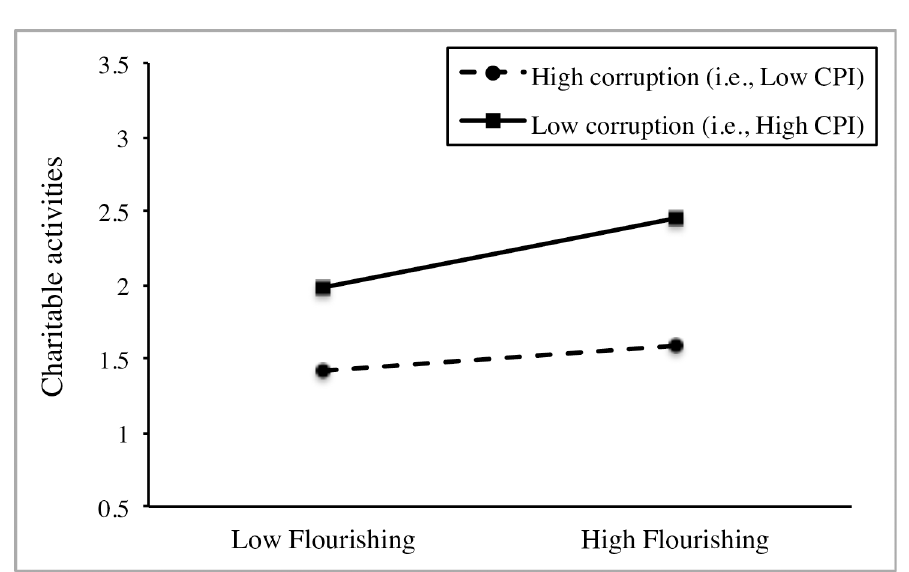
Fig 3. Cross-level interaction between flourishing and CPI on charitable activities in Study